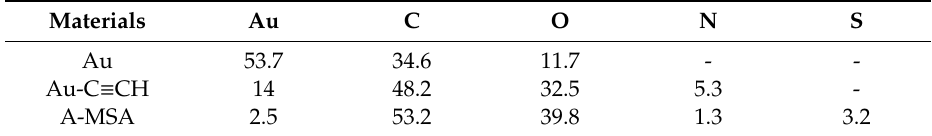
Table 1. XPS-deduced surface chemical composition of untreated and modified gold plates as determined.